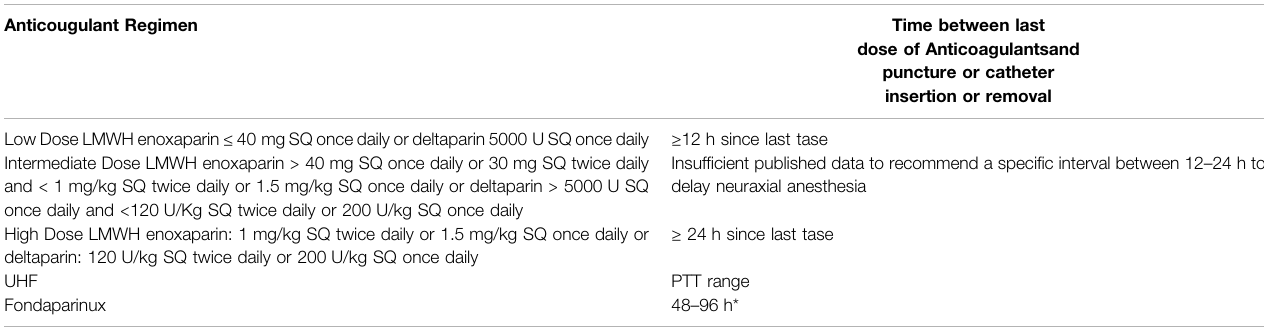
TABLE 2 | Time between last dose of Anticoagulants and puncture or catheter insertion or removal. Anticougulant